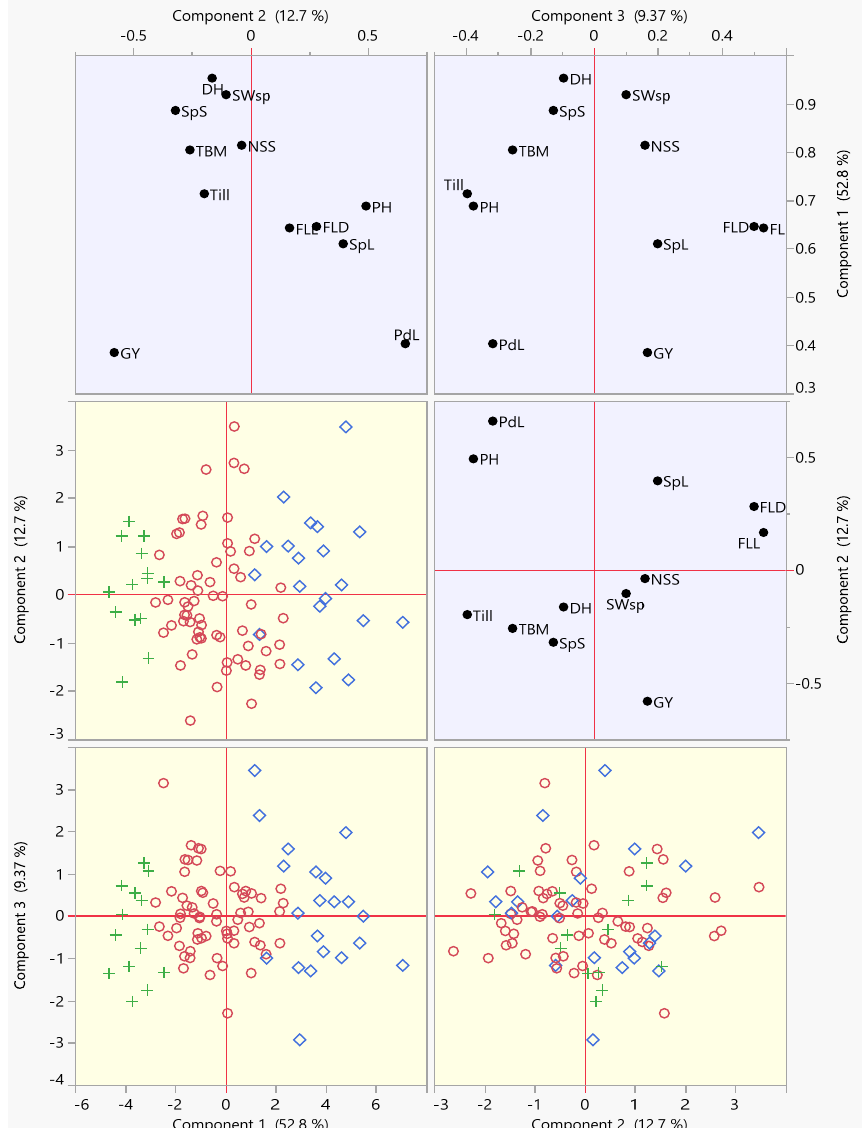
Figure 5. The Scatterplot matrix of first three PCs arranging score plots (yellow background) and loading plots (blue background) for all studied traits of experimental wheat genotypes, including parents and RILs in one space. The loading-plots (blue background) showed the correlation between traits in question and the three PCs. The score plots (yellow background) are exhibiting the distribu- tion of diploid wheat genotypes with colored dots for the representation of genotype groups. The red dots depicted Clade-I genotypes (with parent T. boeoticum ), and green dots are for the representation of Clade-II genotypes, while the blue dots represent Clade-III genotypes (with parent T. monococcum